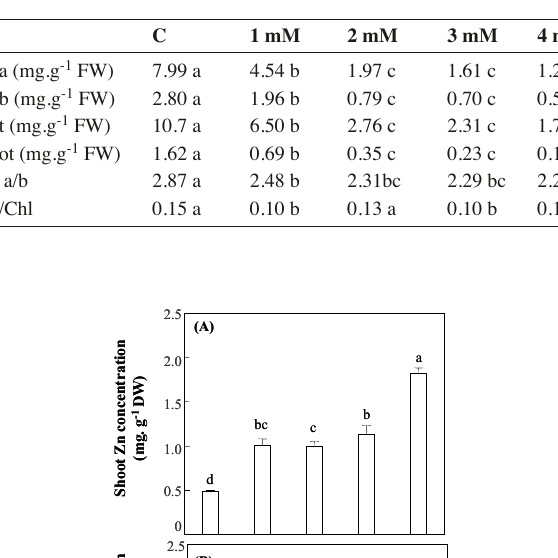
Tab. 1: Effect of Zn supply on leaf pigment content of fenugreek plants grown with different Zn concentrations for 52 days. Values (means SE of three replicates) followed by the same letter are not significant - ly different (Duncan test, P=0.05).